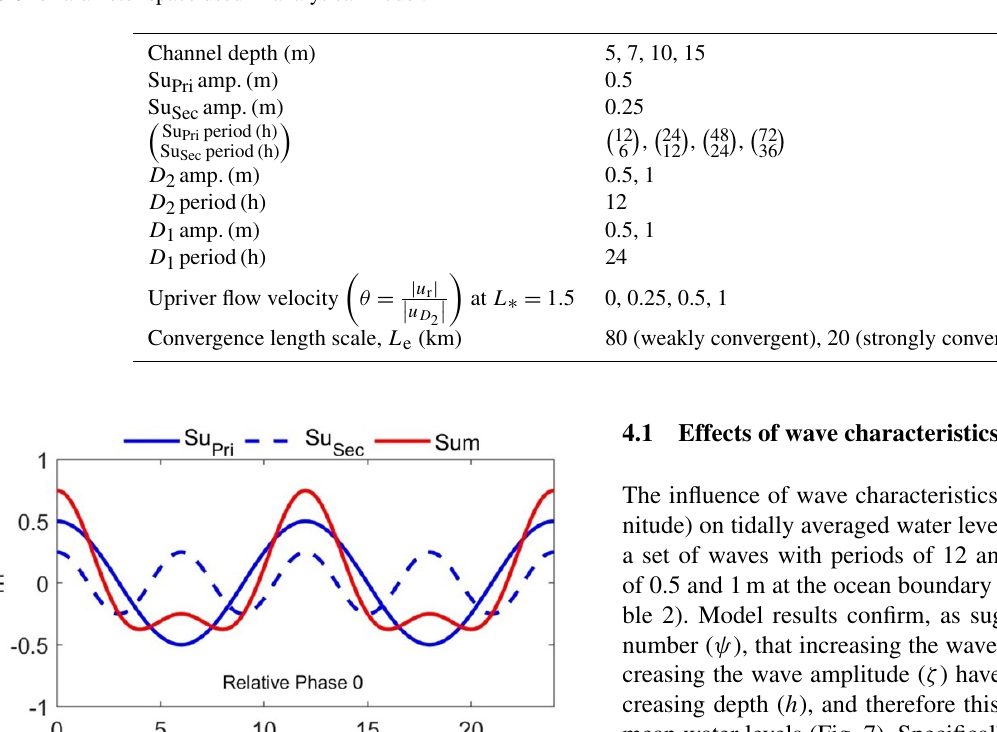
Table 2. Parameter space used in analytical model.